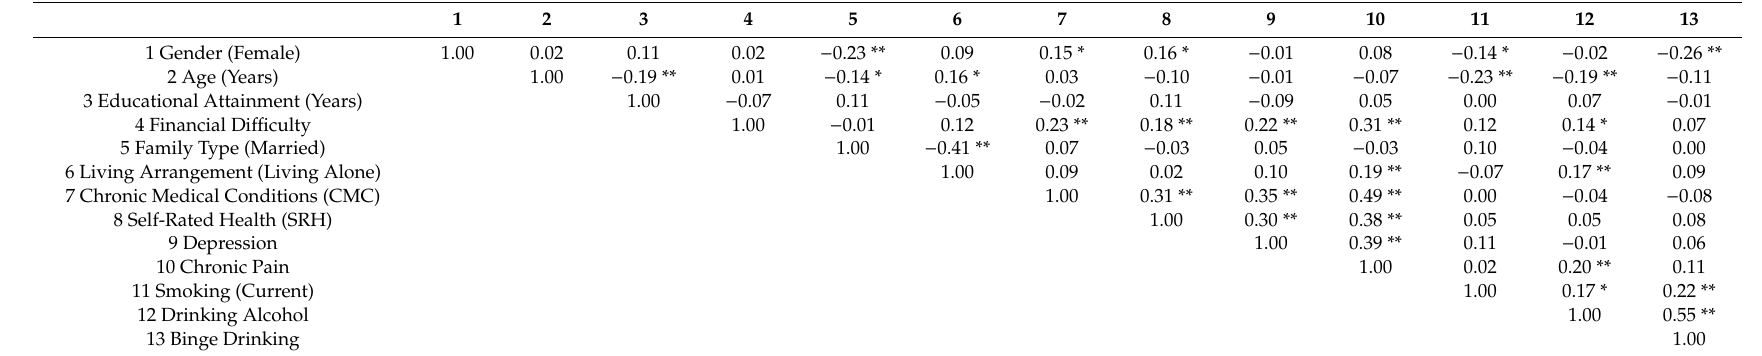
Table 2. Bivariate